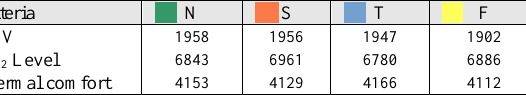
Table 4. S0 (N, S, T, F) showing the basic comfort values for the basic HDS models h/8760.